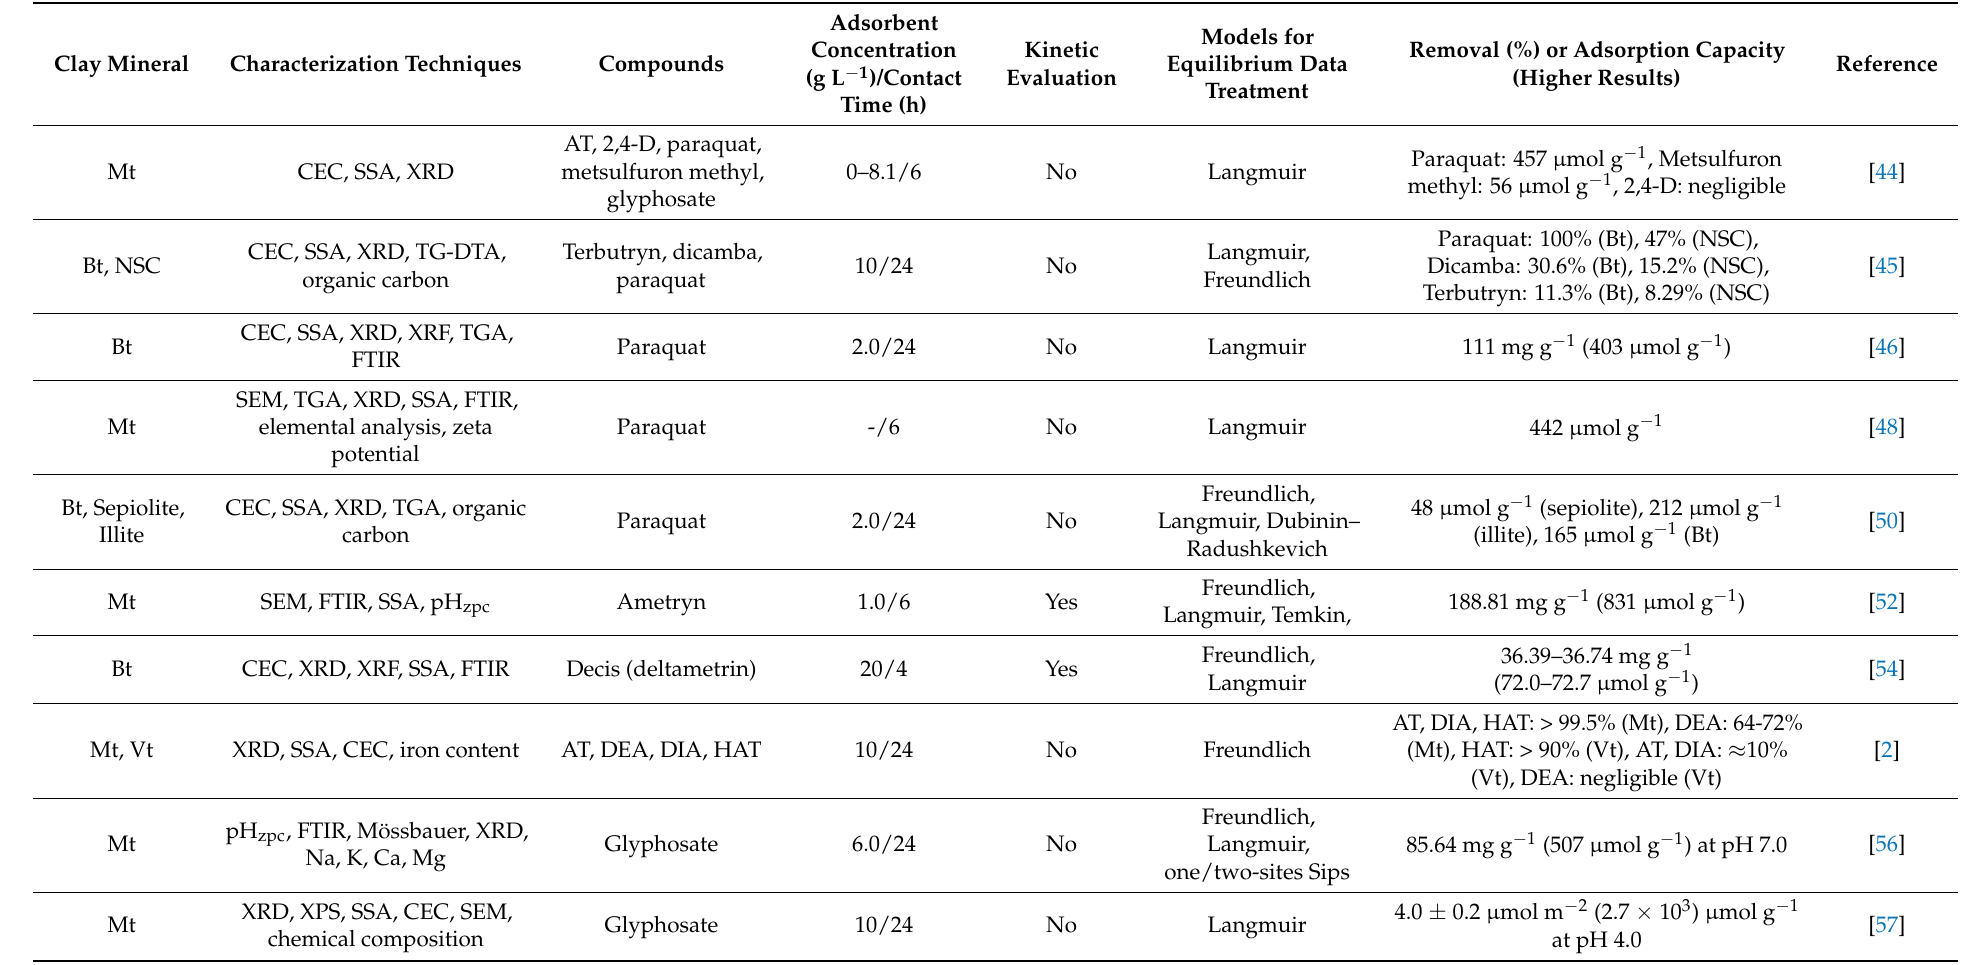
Table 2. Sorbent characterizations and sorption features of pesticides and metabolites onto natural clay minerals.